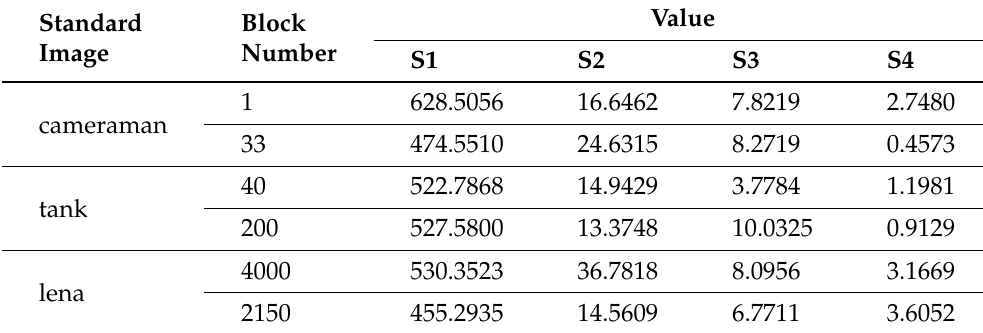
Table 1. Values of the singular matrix for some blocks of the standard images. Standard